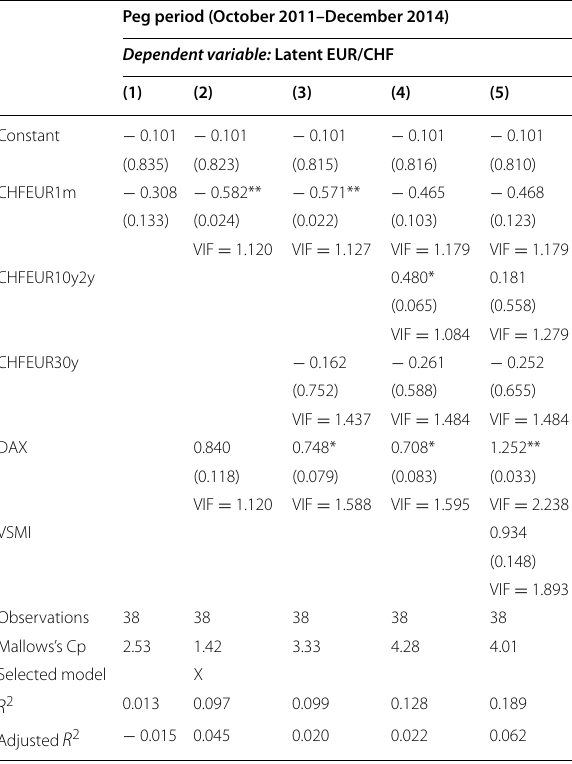
Table 4 OLS regression results for the peg period (October 2011– Table 5 OLS regression results for the peg period (October